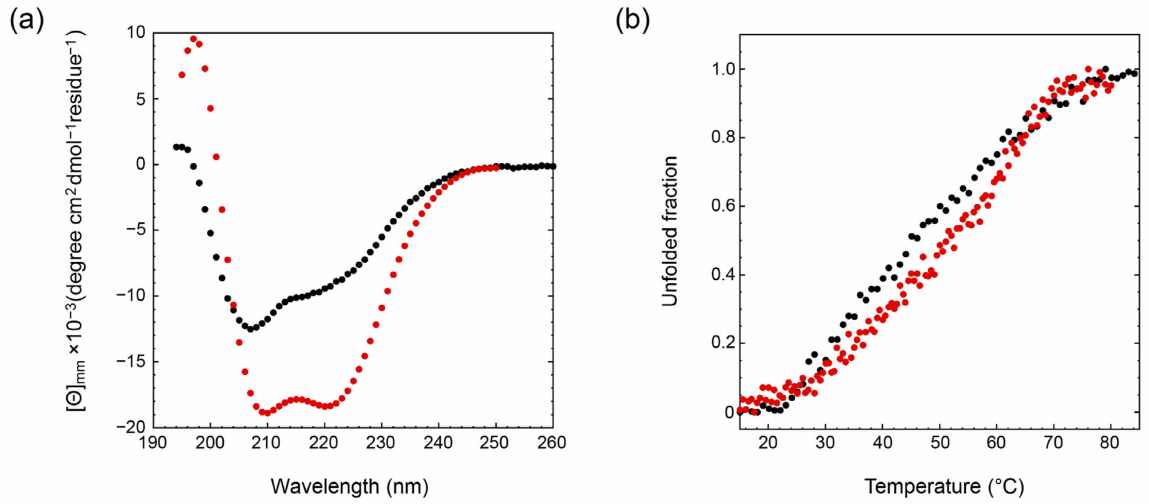
Figure 4. Circular dichroism of the EspK full-length protein (black) and its C-terminal region (red). ( a ) Far-UV spectra. ( b ) Thermal